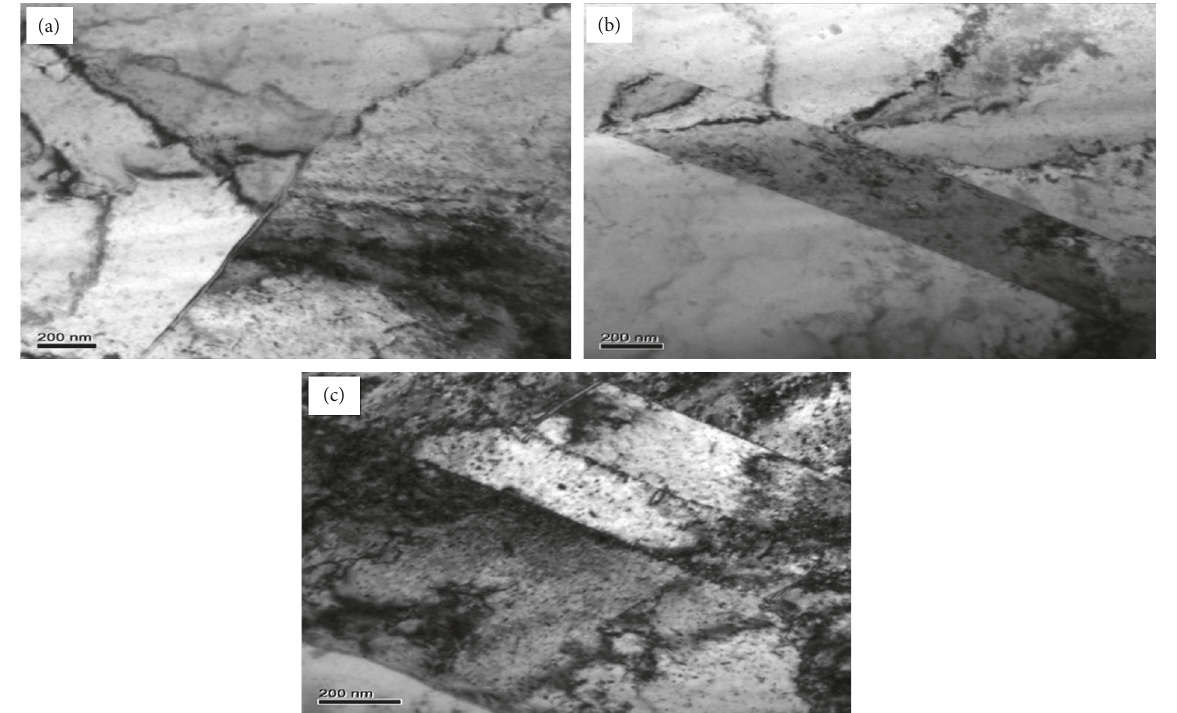
Figure 8: SZ (a) dislocation structure, (b) twin structure, and (c)